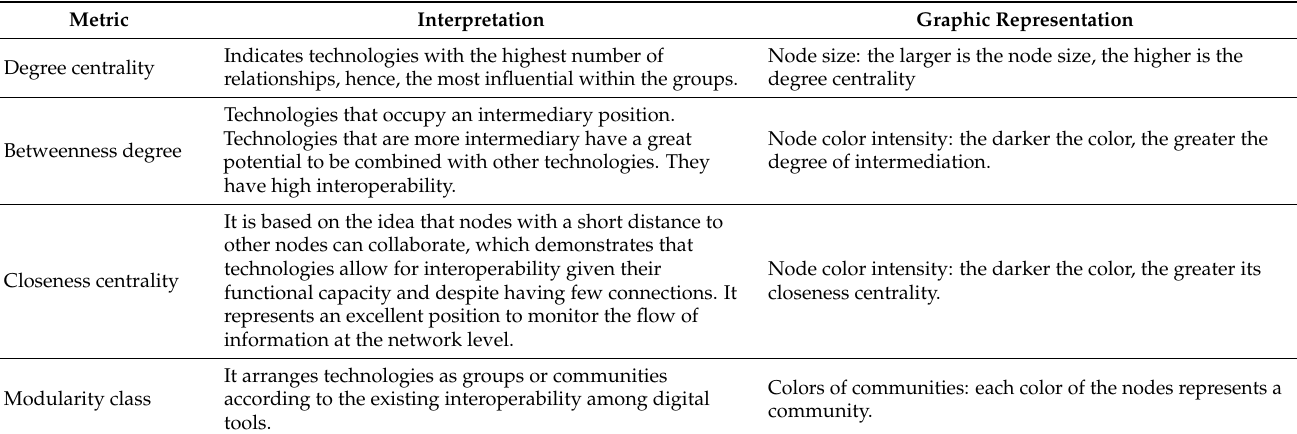
Table 11. Interpretation and graphical representation of network analysis.